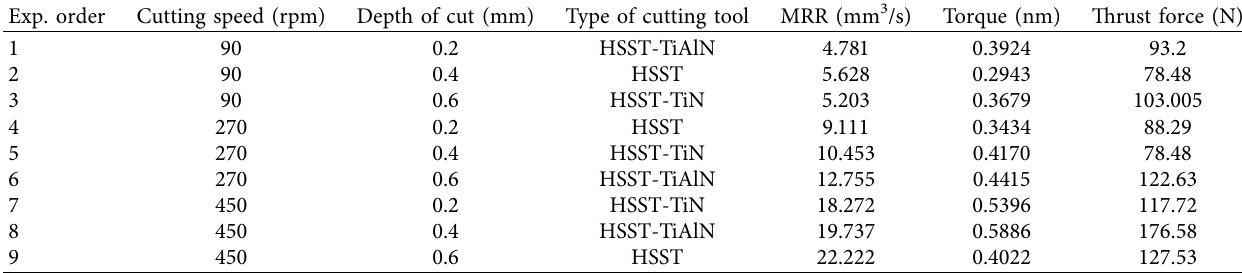
Table 7: MRR, Torque, and Thrust force values for the corresponding input factor. Exp. order